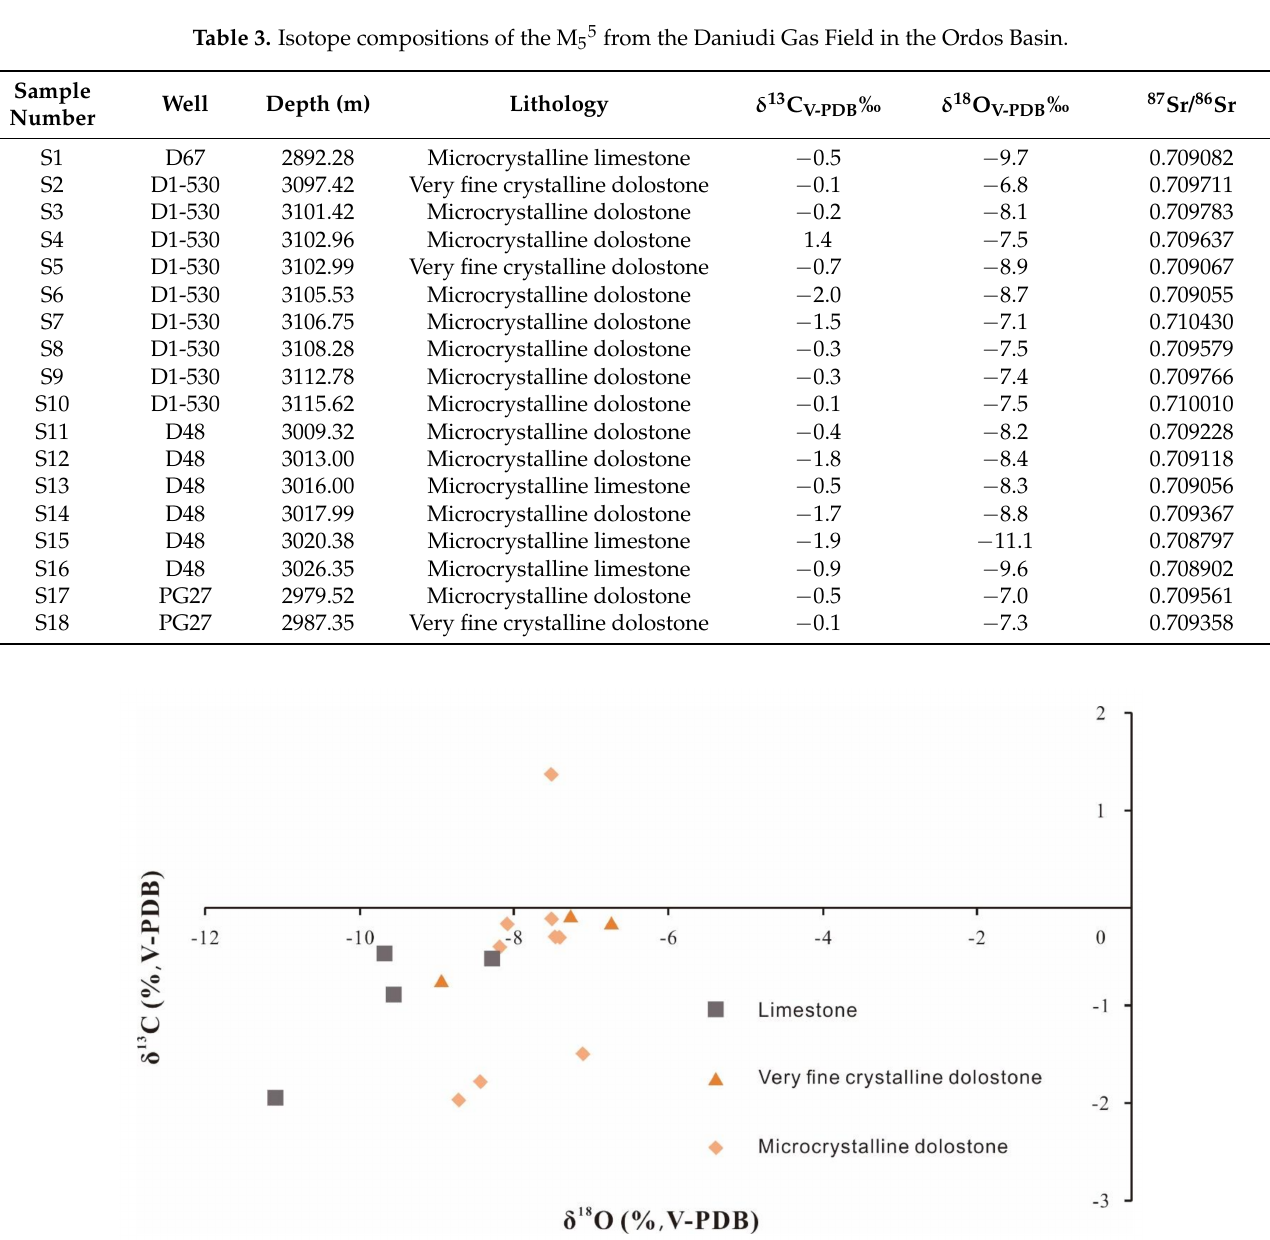
Figure 4. δ 13 C and δ 18 O of different lithologies in M 5 5 in Daniudi Gas Field, Ordos